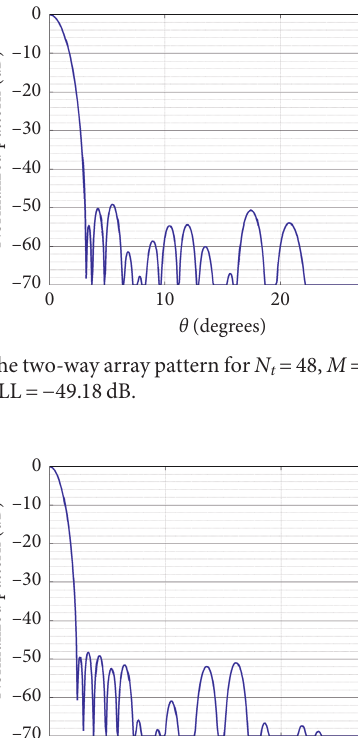
Figure 13: The two-way array pattern for N � 62, N � 46 and t r M � 22. SLL ∼ −